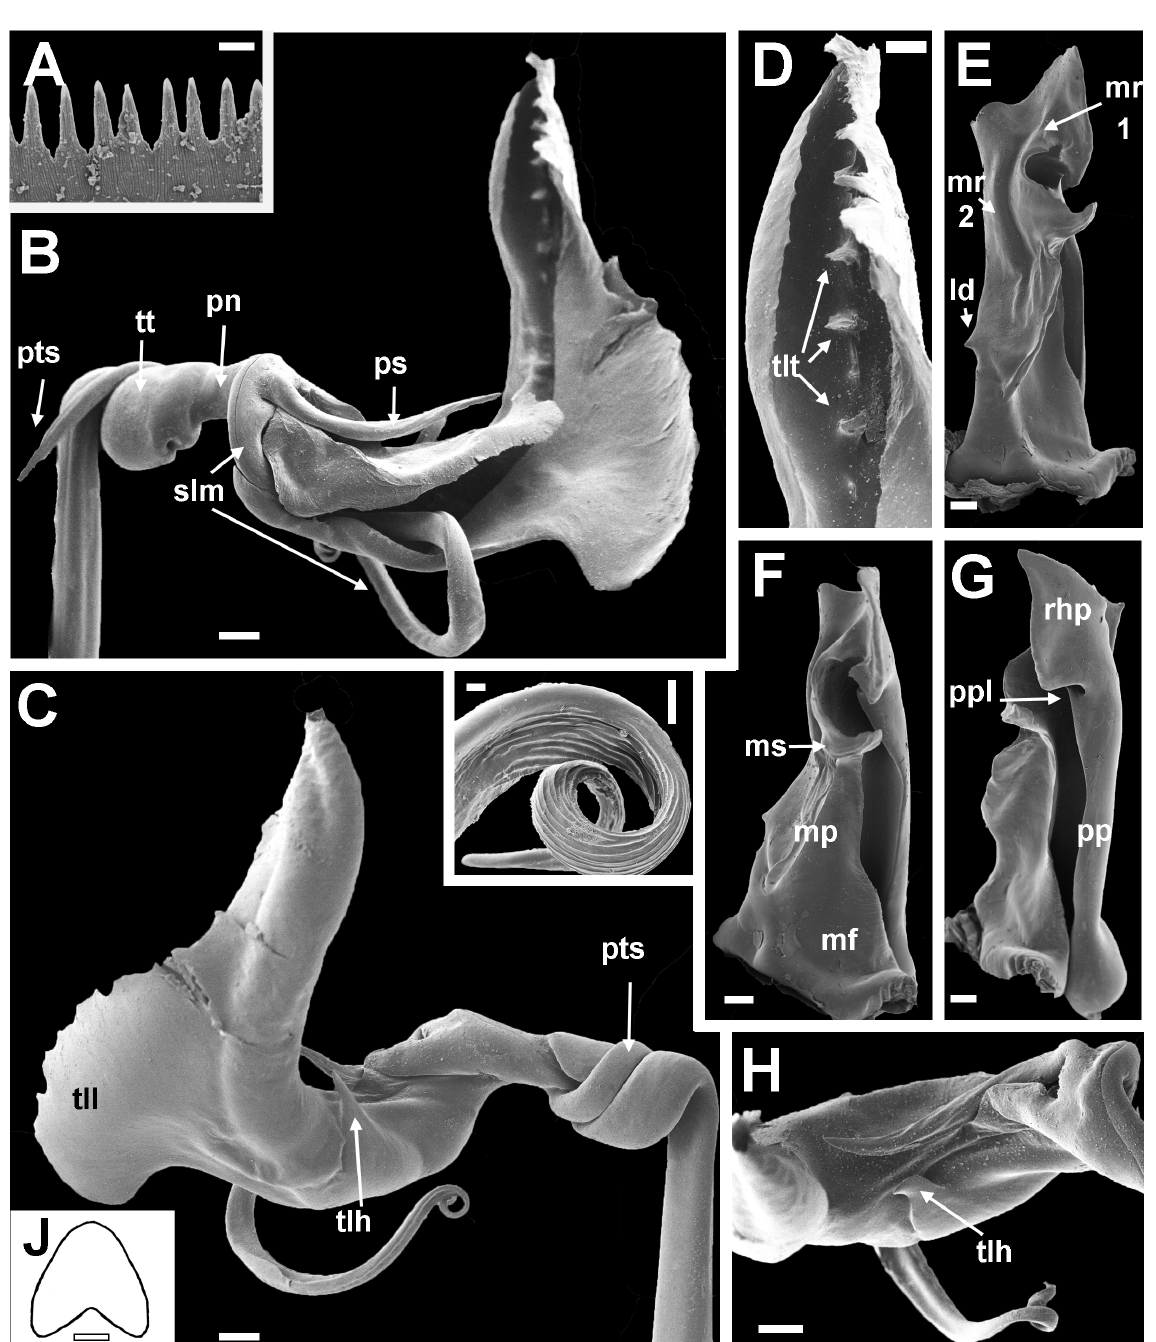
Fig. 2. Damacornu transversum gen. et sp. nov., holotype. A . Limbus. B–I . Right gonopod. B . Telopodite, posterior view. C . Telopodite, anterior view. D . Terminal process of telomeral lamella, posterior view. E . Coxa, posterior view. F . Coxa, mesal view. G . Coxa, anterior, slightly mesal view. H . Basal part of telomere, ventral view. I . Tip of solenomere. J . Sternum of rudimentary ninth leg-pair. Abbreviations: ld = lateral denticle of coxa; mf = metaplical flange; mp = metaplica; mr1 , mr2 = metaplical ridges; ms = metaplical shelf; pn = post-torsal narrowing; pp = proplica; ppl = proplical lobe; ps = proximal solenomeral spine; pts = post-torsal spine; rhp = rhomboidal plate; slm = solenomere; tlh = hook-shaped telomeral process; tll = telomeral lobe; tlt = telomeral teeth; tt = torsotope. Scale bars: A = 0.01 mm; B–C, E–H = 0.2 mm; D = 0.1 mm; I = 0.02 mm; J = 0.5